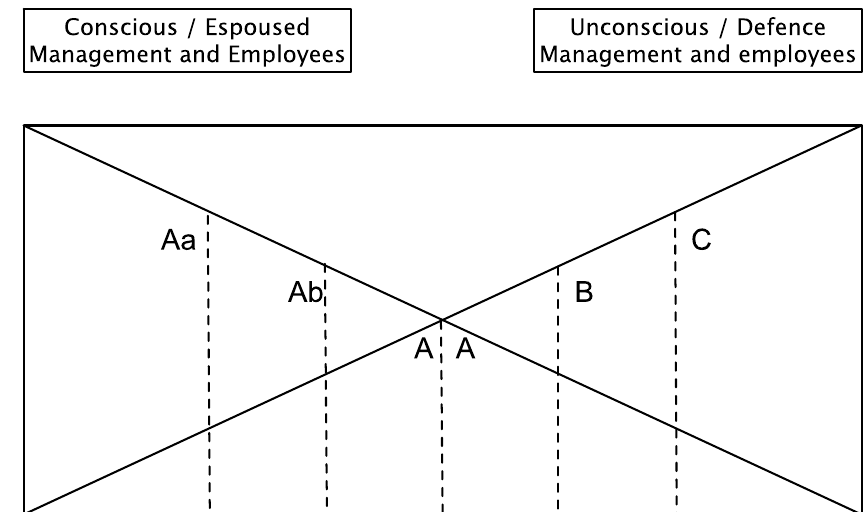
Figure 6. OI intertwined with OL.